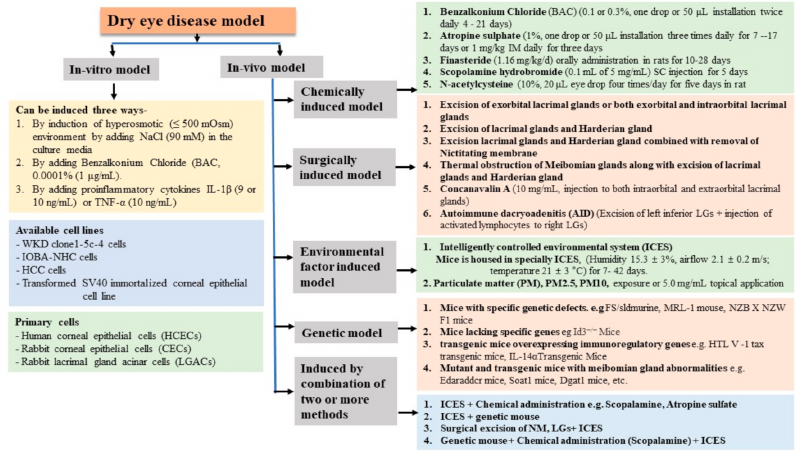
Figure 2. Classification of various dry eye